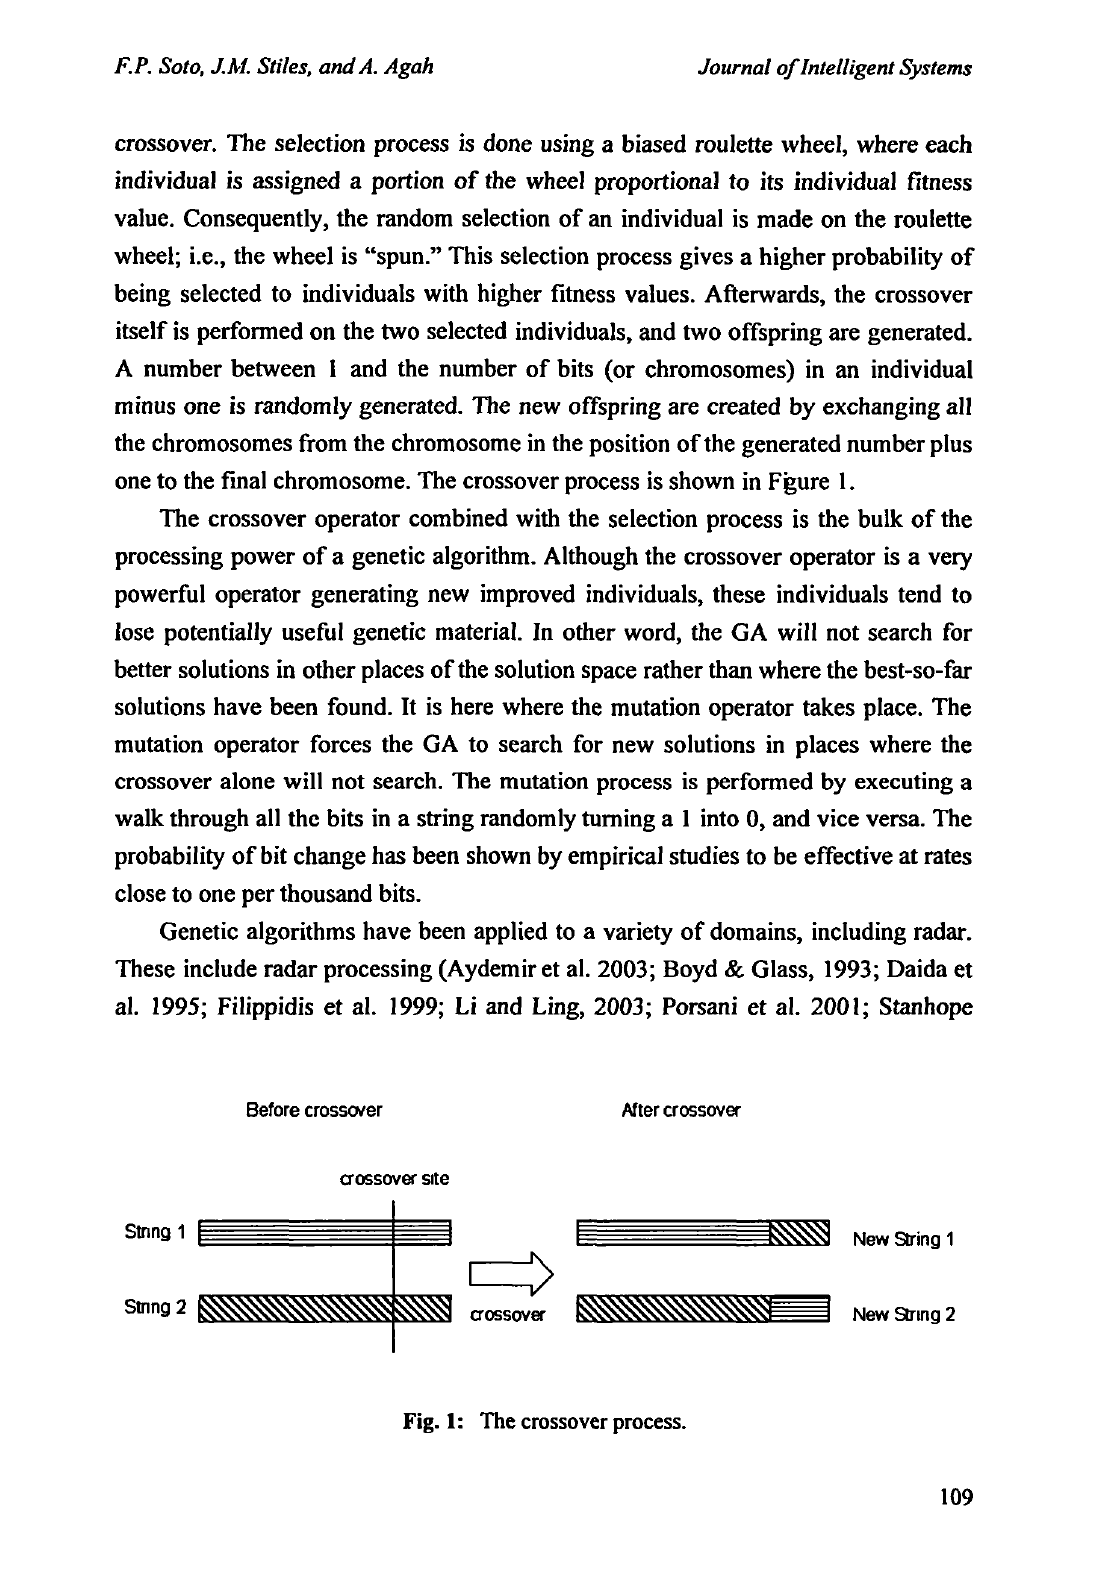
Fig. 1: The crossover